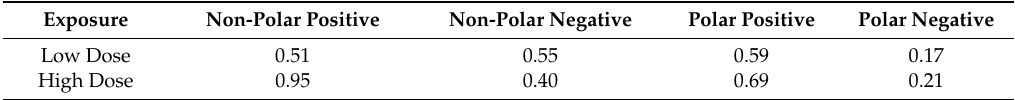
Table 1. AUCs of the random forest classifiers comparing the negative control group against the di ff erent exposures.